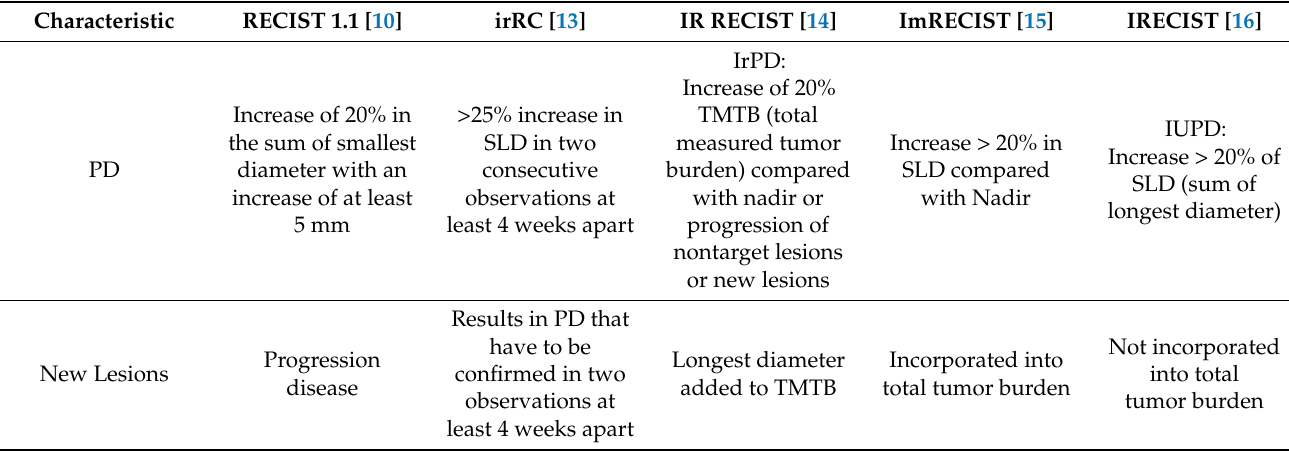
Table 1. Comparison between RECIST 1.1; irRECIST, iRECIST,